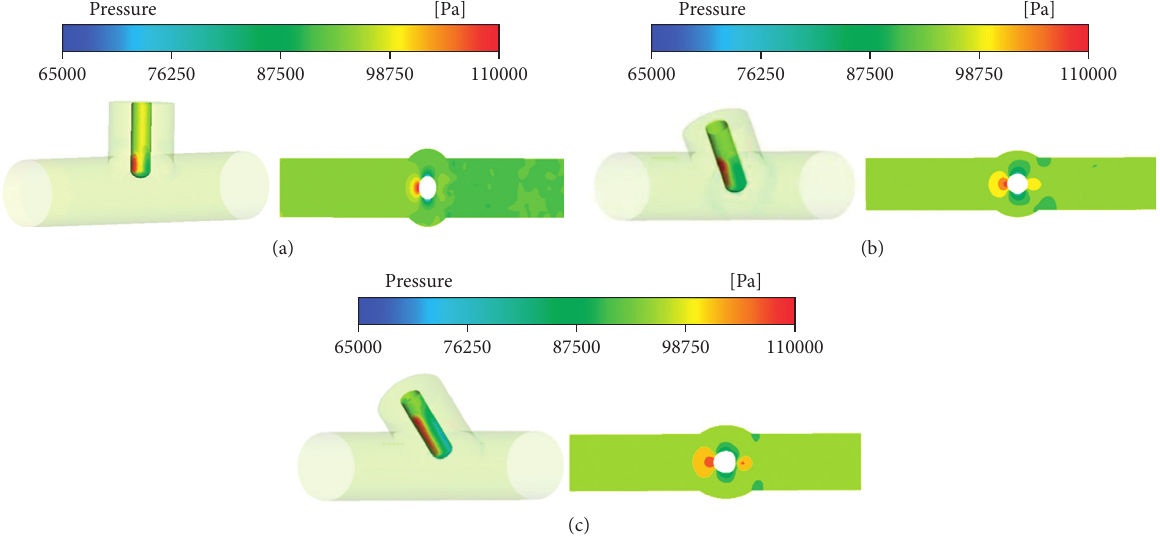
Figure 15: Pressure contours. (a) Pressure nephogram of 90 ° installation angle. (b) Pressure nephogram of 60 ° installation angle. (c) Pressure nephogram of 45 ° installation